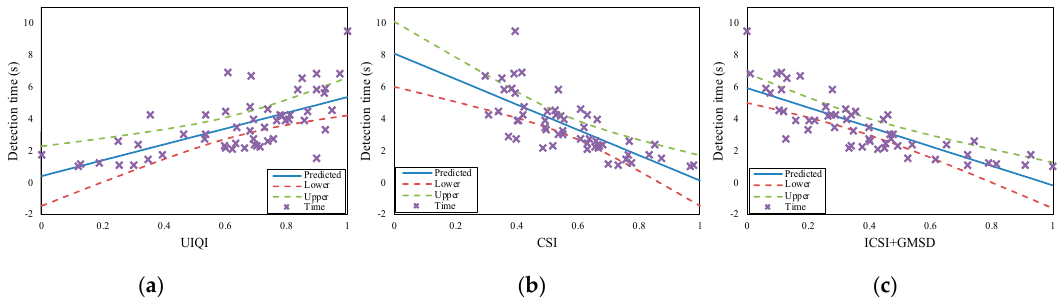
Figure 4. The correlations of the ( a ) CSI, ( b ) UIQI and ( c ) ICSI + GMSD for detection time.